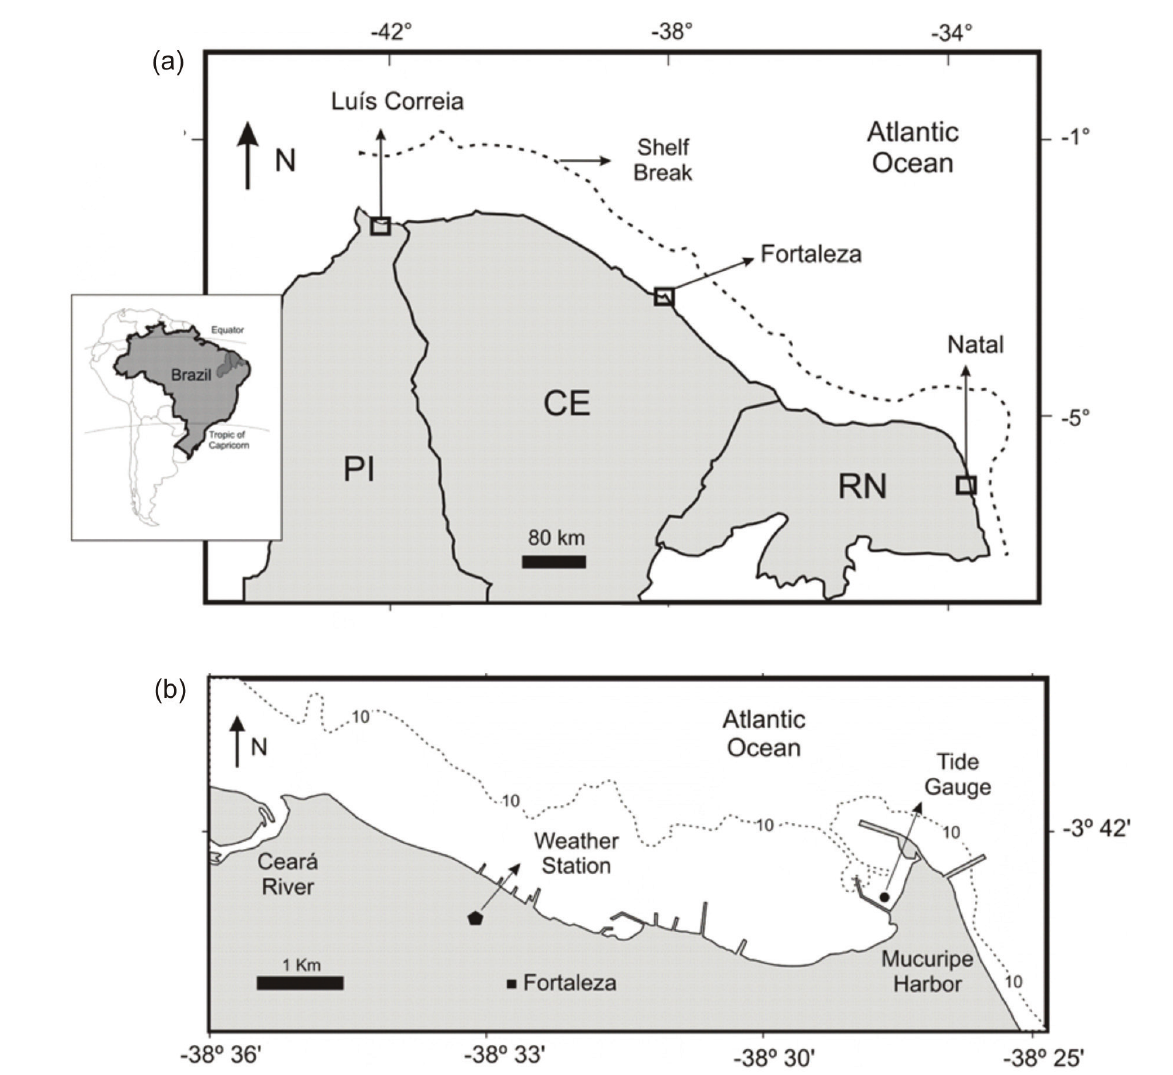
Figure 1 - (a) The northern Brazilian Northeast Continental Shelf and (b) details of the Fortaleza shore showing the tide gauge and meteorological